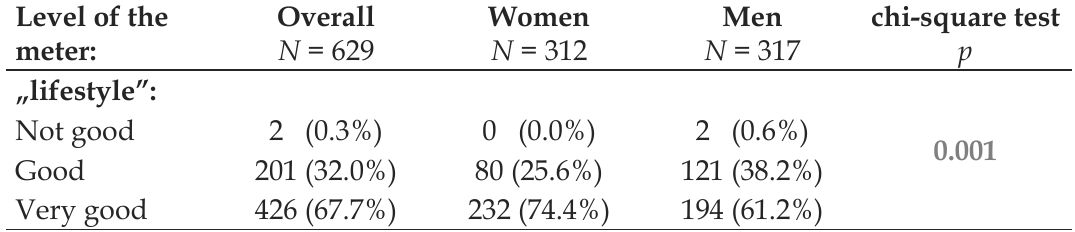
Basic statistics (numbers and proportions) SPM “lifestyle” due to gender Level of